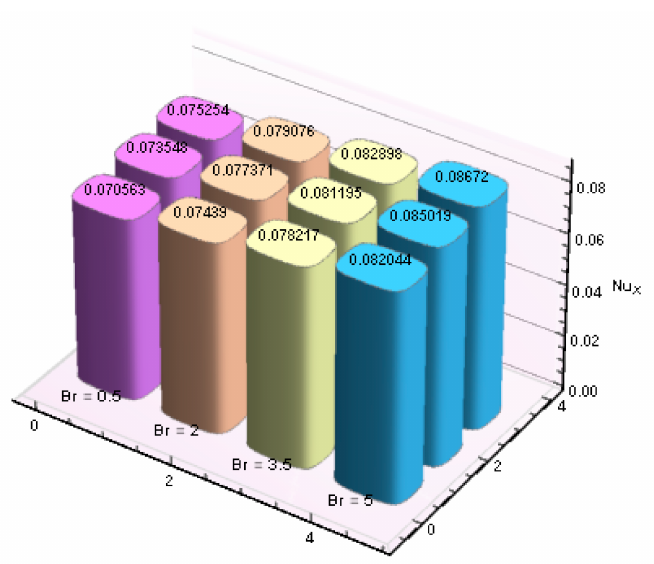
Figure 15. Variation in Nu x against Br .